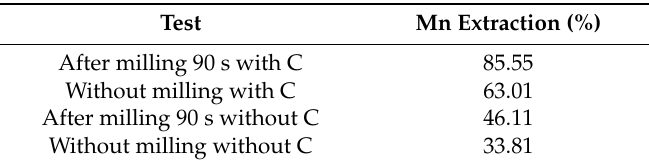
Table 5. Test carried out at 200 ◦ C for 45